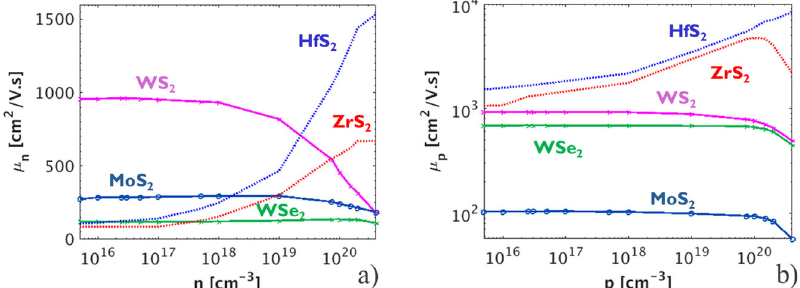
Fig. 5 Electron – phonon-limited mobility. Intrinsic electron – phonon-limited mobility vs carrier concentration in a n- and b p-type TMD transistors. The mobilities were extracted from our DFT-NEGF simulations using long-channel devices (for several channel L ranging from 100 nm to 1 μ m typically) at V D = 50 mV. The L -independent ballistic resistance was removed from the extraction by using the dR/dL method 32 . HfS 2 and ZrS 2 results are shown along the Γ K channel orientation and include polar-optical phonons using a Fröhlich